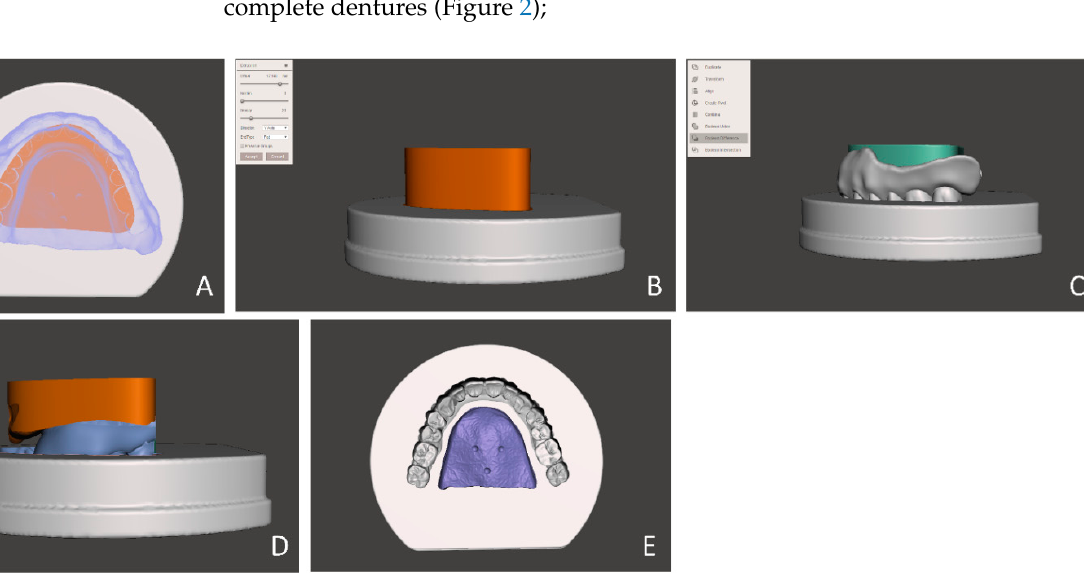
Figure 2. Design process for the primary geometry guide of the maxillary denture. ( A ) Selecting the region covering the metal base and artificial teeth on a base structure. ( B ) Extruding the selected area in a vertical direction. ( C ) Applying “Boolean Difference” command between the base structure and denture to eliminate the area occupied by the denture. ( D ) Discarding the upper structure after the command is performed. ( E ) Inspecting the primary geometry guide.